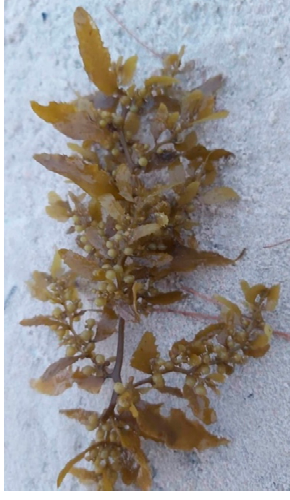
Figure 1. Sargassum spp. collected from